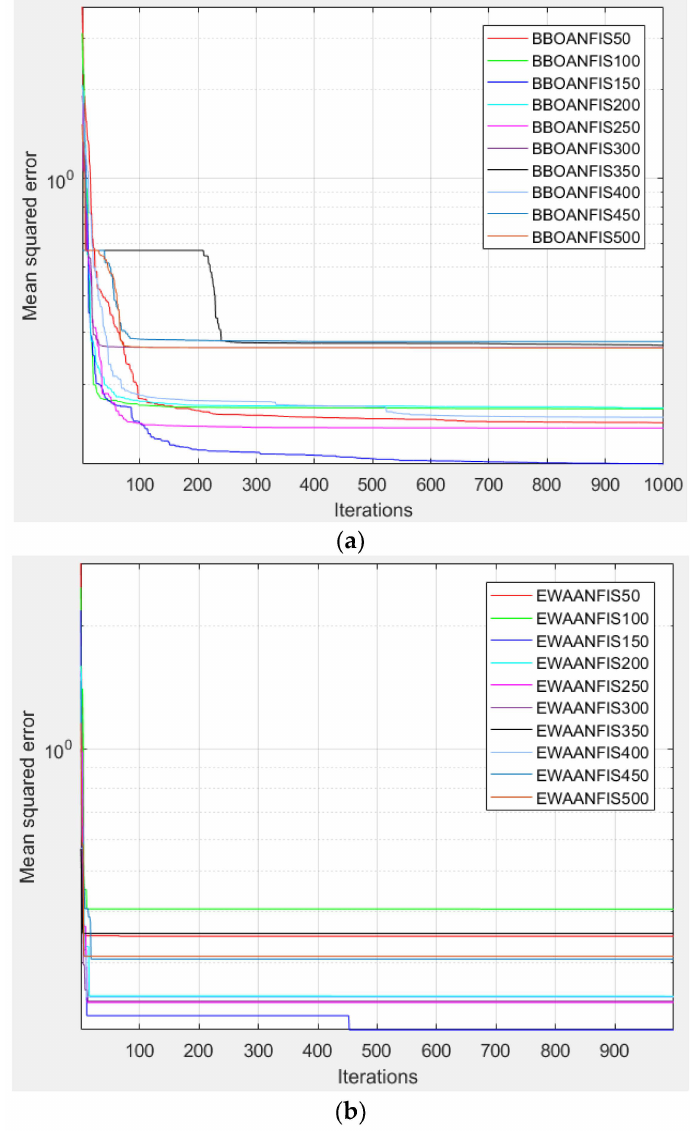
Figure 4. Variation of mean squared error versus iterations for the ( a ) BBOANFIS, ( b ) EWA-ANFIS. Table 2. The network results for the BBOANFIS for different swarm